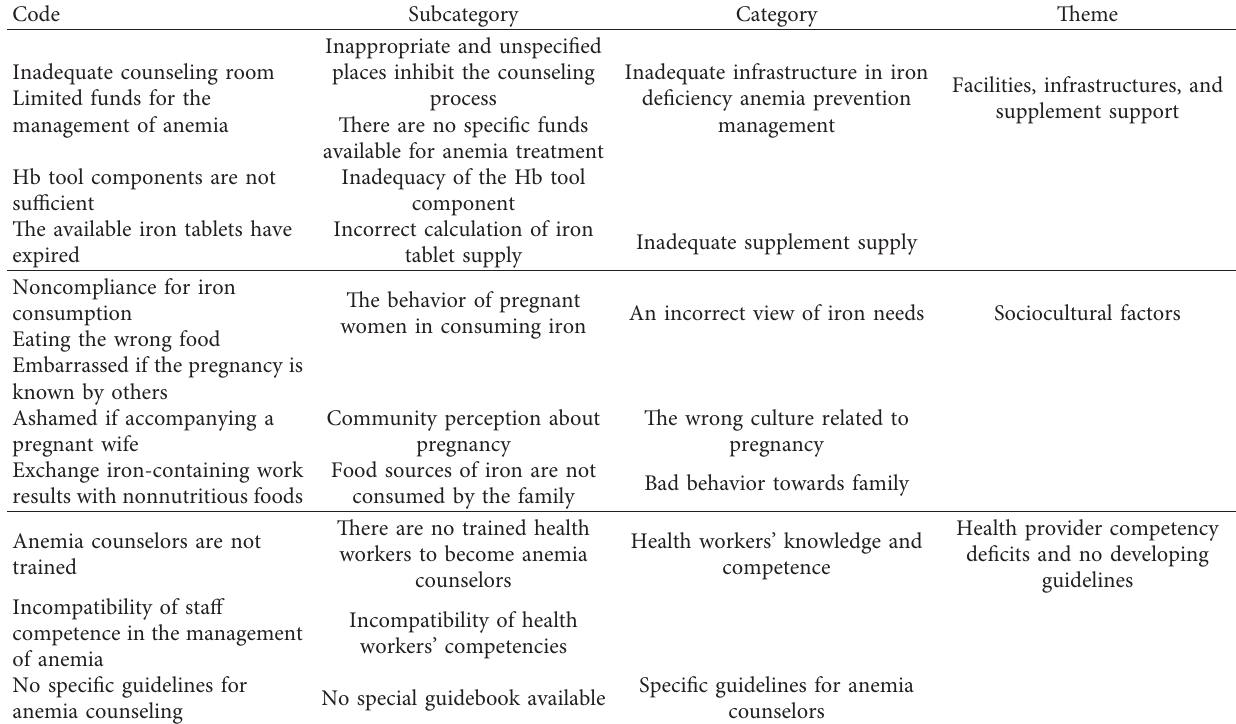
Table 2: Major findings with code, subcategories, categories, and